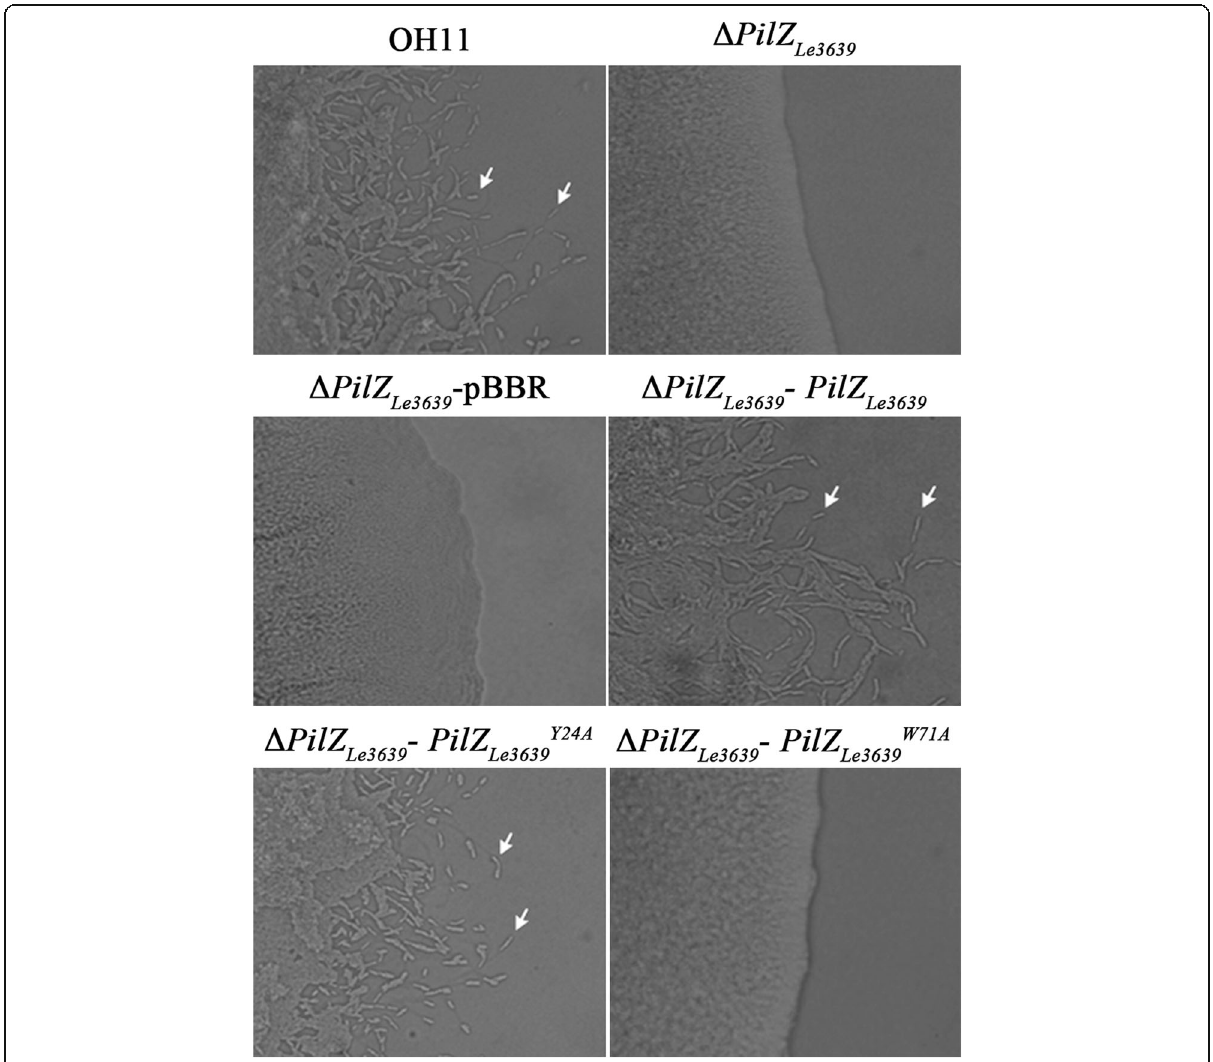
Fig. 2 PilZ Le3639 and its residue W71 both played essential roles in the formation of twitching motility by L. enzymogenes . Mutation of pilZ Le3639 in wild-type OH11 led to a complete defect in forming twitching motility, as no twitching cells (indicated by blight arrows) were observed at the margin of strain colony. Complementing the wild-type PilZ Le3639 or a variant carrying a Y24-A24 substitution (indicated as Y24A) into the mutant both rescued this motile deficiency. Introducing the empty vector (pBBR1-MCS5, abbreviated as pBBR) or the pilZ Le3639 variant possessing a W71- A71 replacement (indicated as W71A) failed to rescue the twitching deficiency of the pilZ Le3639